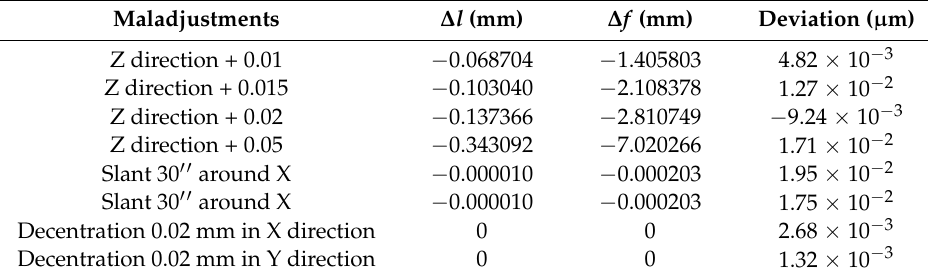
Table 2. Simulation calculation results of the proposed method.